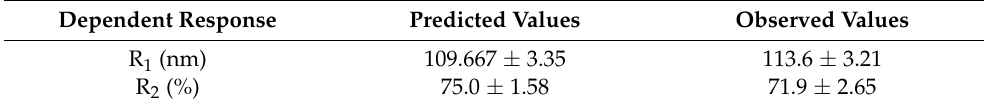
Table 3. Predicted and observed values of response at the optimal conditions.